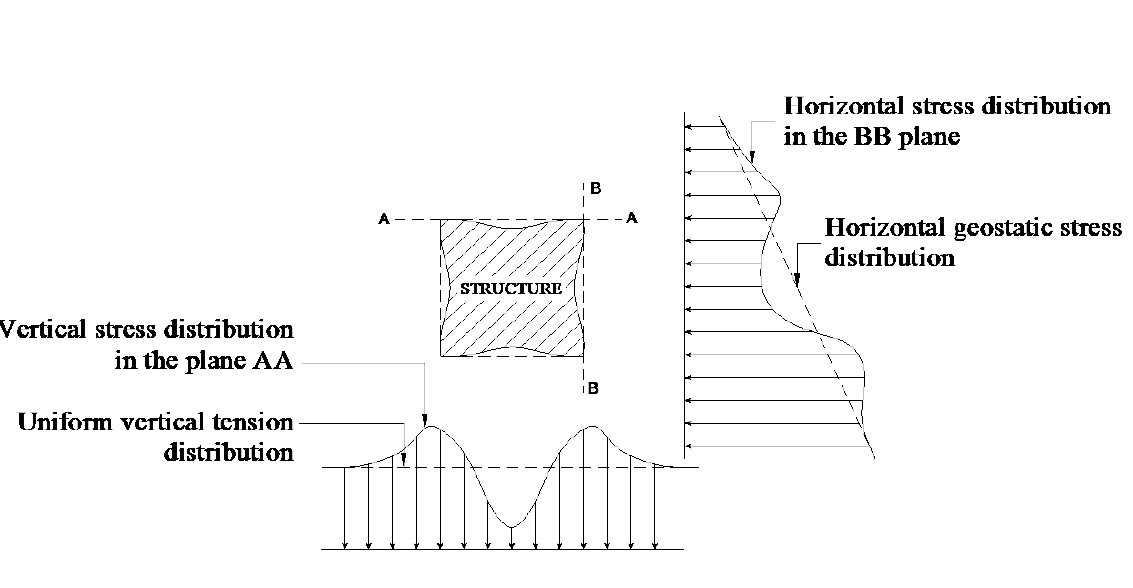
Figure 2. Stress distribution in a flexible rectangular